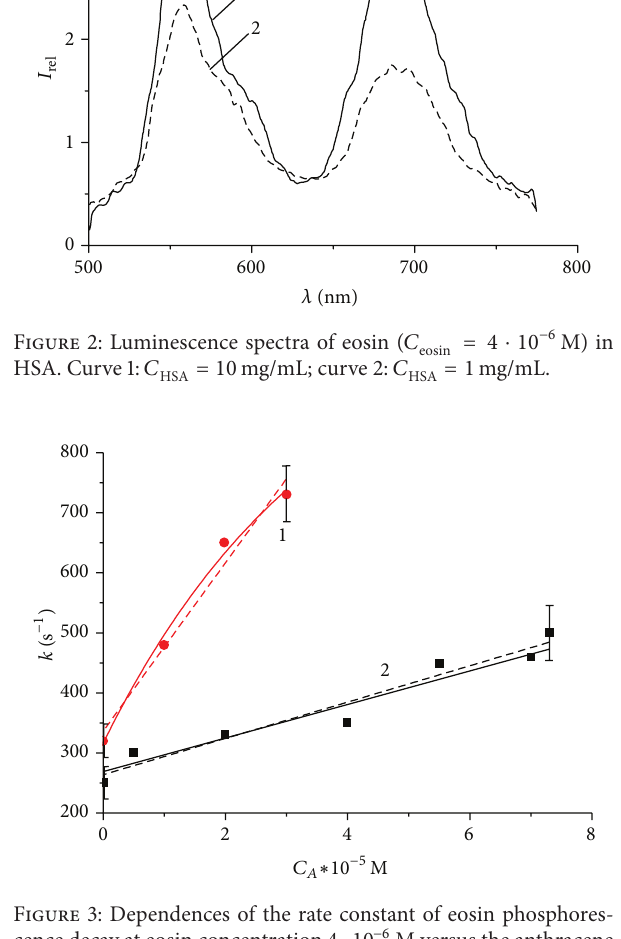
Figure 3: Dependences of the rate constant of eosin phosphores- cence decay at eosin concentration 4 ⋅ 10 −6 M versus the anthracene concentration 𝐶 𝐴 , both bound to serum albumin. HSA concentra- = 1 mg/mL (curve 1) and 𝐶 = 10 mg/mL (curve 2). tion is 𝐶 HSA HSA The points represent experimental data, the dashed lines are their least squares approximations, and the solid lines are obtained by